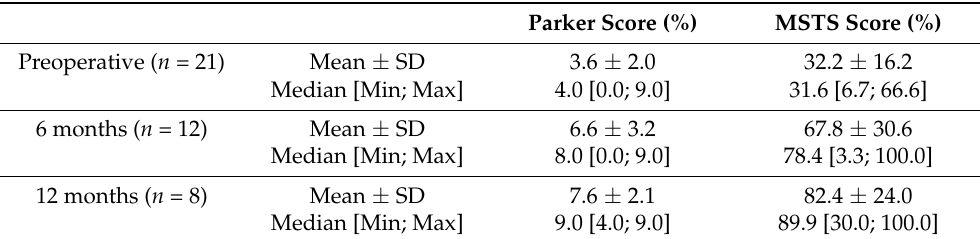
Table 2. Functional score assessment with Parker score and Musculoskeletal Tumor Society score following Harrington